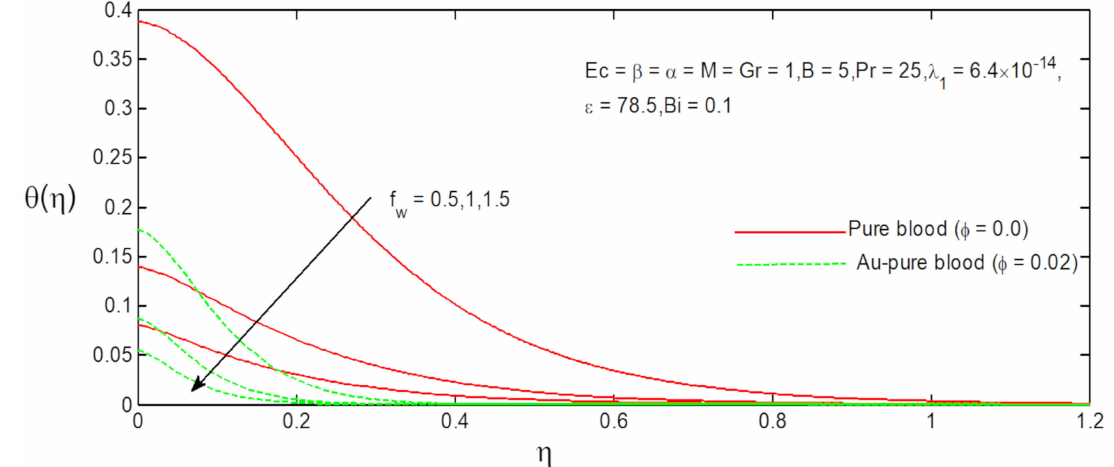
Figure 5. Influence of f w on θ ( η ) .